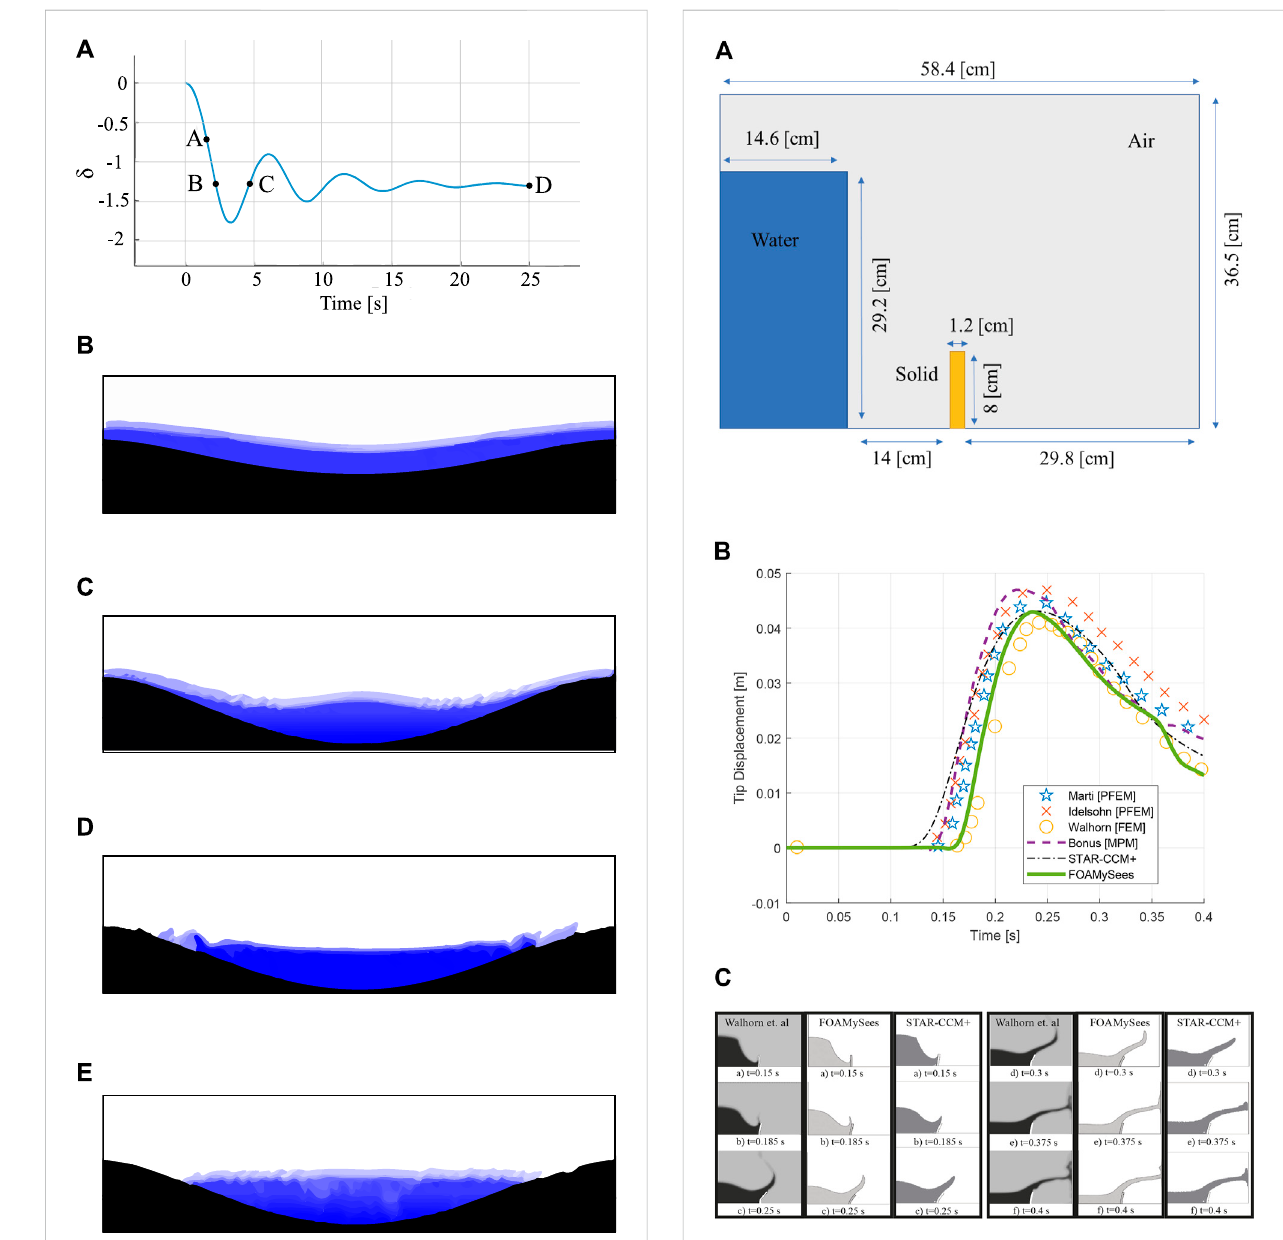
FIGURE 10 (A) FOAMySees solution: Center span displacement of E = 1E6 beam under shifting water loading, (B) point A (1.5 s), (C) point B (2.2 s), (D) point C (4.7 s), (E) point D (25 s).